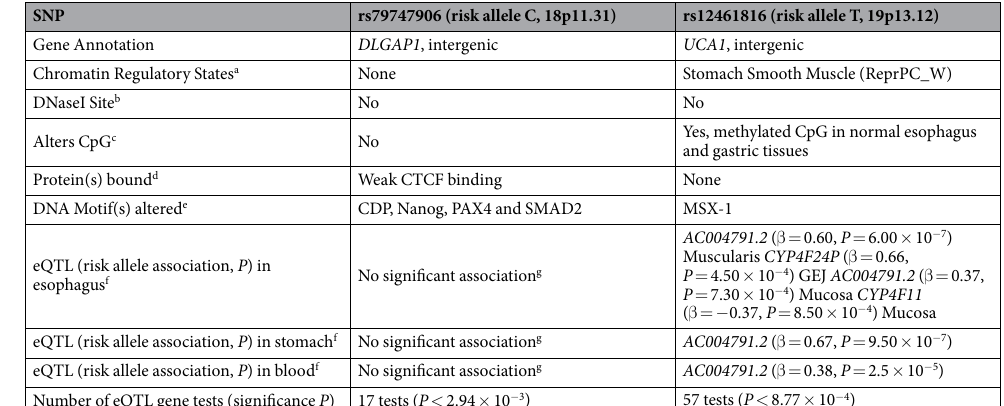
Table 3. Functional annotation of rs79747906 and rs12461816. a Chromatin State Segmentation using a Hidden Markov Model (ChromHMM) by Auxillary Core Marks + K27Ac in adipose derived mesenchymal stem cells (ASC), adipose nuclei (AN), blood cells (CD19, CD8 and CD4), stomach mucosa (SM), stomach smooth muscle (SMM), gastric and esophagus tissues issues from Roadmap (http://www.roadmapepigenomics.org/). Repressed histone methylation (Re), Repressed polycomb weak (ReprPC_W), Repressed polycomb(ReprPC), Heterochromatin (H), Transcription (T), Quiescent (Q), and Enhancer (E). b DNaseI Hypersensitivity sites were assigned by DNase I hypersensitive assay in 125 cell types in ENCODE (http://genome.ucsc.edu/ENCODE/) and in NIH Roadmap data. c DNA CpG altered in esophagus and stomach tissues from NIH Roadmap data. d Transcription binding sites and binding motif defined by chromatin immunoprecipitation sequencing for 161 factors were obtained from ENCODE and HaploReg v4. e DNA binding motifs for transcription factors (TF) and proteins obtained from HaploReg v4. DNA motifs were assigned to a factor group based on TF ChIP experiments and known DNA motifs as described by Keheradpour P and Kellis M 25 . f Expression quantitative trait loci (eQTL) analysis were conducted in normal esophageal tissues: esophageal mucosa[Mucosa]; esophageal muscularis [Muscularis]; and gastroesophageal junction [GJE], normal stomach mucosa, and the whole blood. We examined coding and non-coding genes in cis or located within a 1MB of the signal and known to be expressed at the mRNA in the target tissue. Results were obtained from the Genotype-Tissue Expression (GTEx) Project (http://www.gtexportal.org/home/). P- values were calculated based on linear regression between log and quantile normalized RNA-seq expression values and imputation-based genotype with 3 genotyping principal components, 15 peer factors, and gender as covariates. g No significant association after considering multiple comparisons for number of tests. Suggestive associations with P < 0.05 are shown in SI Table